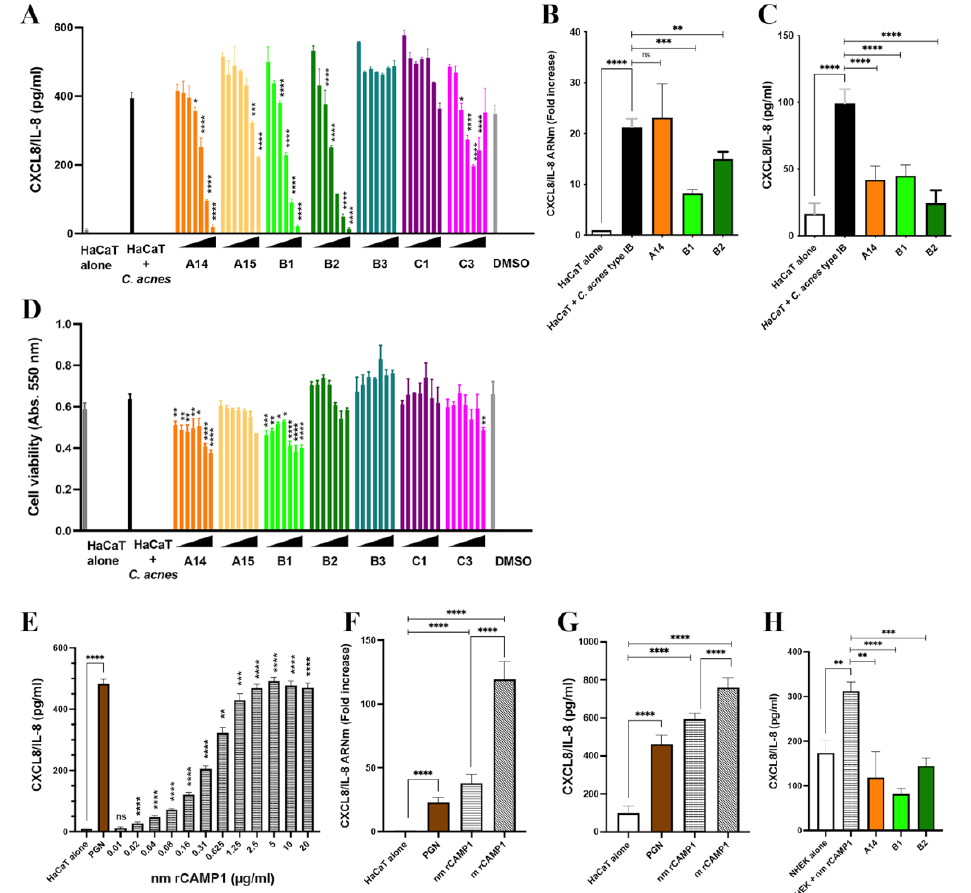
Figure 6. Inhibition of CXCL8/IL-8 production by CAMP1-derived peptides in vitro. ( A – C ) HaCaT cells were treated with A14, A15, B1, B2, B3, C1 and C3 peptides at a concentration of 3.9 to 250 µ M or with A14, B1, B2 peptides (62.5 µ M) for 24 h and were then stimulated with C. acnes (MOI 15) for 18 h. The negative control consists of untreated and unstimulated cells (HaCaT alone). The positive control corresponds to cells stimulated with C. acnes (HaCaT + C. acnes ). ( D ) Cytotoxicity was assessed in the MTT assay. ( A , D ) Dimethy sulfoxide (DMSO) corresponds to the control experiment with a solution of DMSO/H 2 O 30:70 (v/v) used to solubilize the peptides A14 and A15. ( E ) HaCaT cells were stimu- lated with various concentrations of nmrCAMP1 (0.01 to 20 µ g/mL). The positive control corresponds to cells stimulated with PGN (5 µ g/mL). ( F , G ) HaCaT cells were stimulated with nmrCAMP1 and mrCAMP1 (10 µ g/mL). The positive control corresponds to cells stimulated with PGN (5 µ g/mL). ( H ) Primary normal human epidermal keratinocyte cells (NHEK) were treated with A14, B1 and B2 peptides at a concentration of 62.5 µ M for 24 h at 37 ◦ C and stimulated with nmrCAMP1 (10 µ g/mL) for 18 h. The negative control was the untreated and unstimulated cells (NHEK alone). The pos- itive control corresponds to cells stimulated with nmrCAMP1 (NHEK + nmrCAMP1). ( B , F ) The level of CXCL8/IL-8 mRNA was assessed by qRT-PCR. ( A , C , E , G , H ) CXCL8/IL-8 production was assessed by ELISA. Statistical significance is indicated by * ( p < 0.05), ** ( p < 0.01), *** ( p < 0.001) and **** ( p <